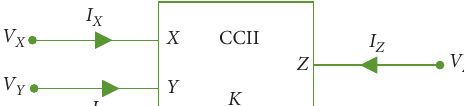
Figure 6: Coexisting attractors for the different parameter values β and c 0 , − 0 . 1 , 0 , 0 􏼂 􏼃 which are shown in blue and red, respectively: (a) coexisting double-scroll chaotic attractors, (b) coexisting single band chaotic attractors, (c) coexisting period-4 limit cycle, (d) coexisting period-2 limit cycle, (e) coexisting period-1 limit cycle, and (f) coexisting time-domain waveform diagram of state x .